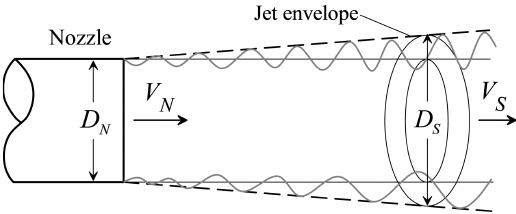
Figure 2. Jet surface